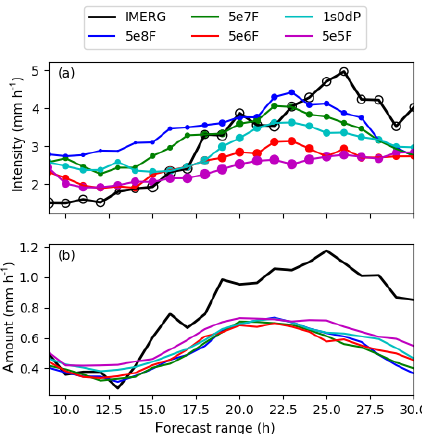
Figure 8. Time series of (a) domain-averaged rainfall intensity (lines) and frequency (circles) and (b) rainfall amount in the mod- els (colours) and IMERG retrievals (black). The time is given in hours elapsed since the initialisation of the forecasts (00:00UTC on 20